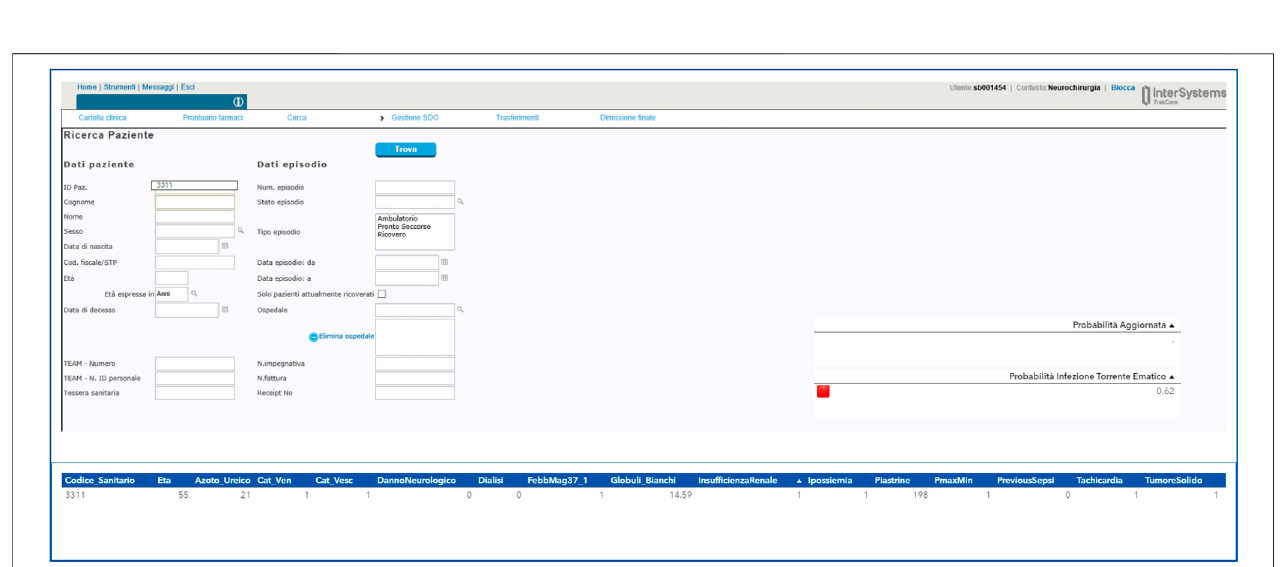
FIGURE 9 | Example of a user interface developed for the Guardian Bot linked to the computerized medical record.